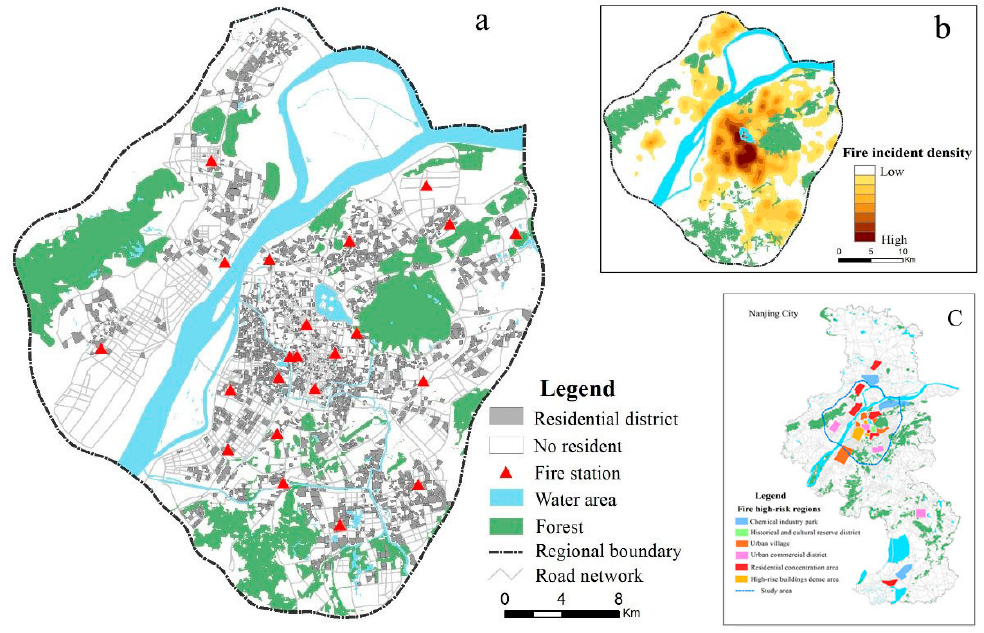
Figure 2. Descriptions of the study area: ( a ) Study area and basic datasets. ( b ) Fire density distribution. ( c ) High-risk fire regions of Nanjing city.